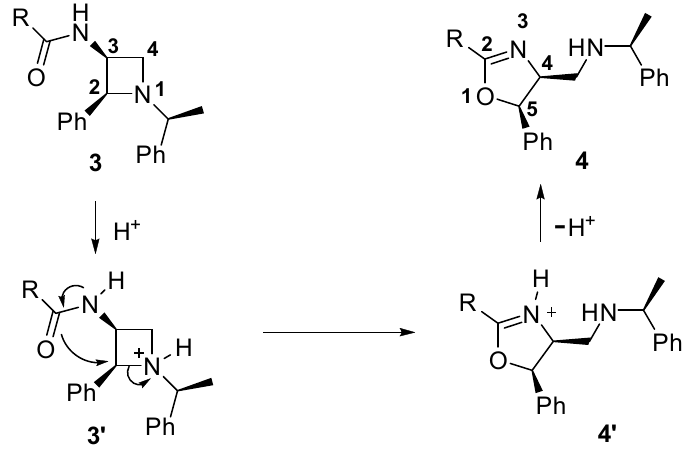
Figure 1. Structure of 4l